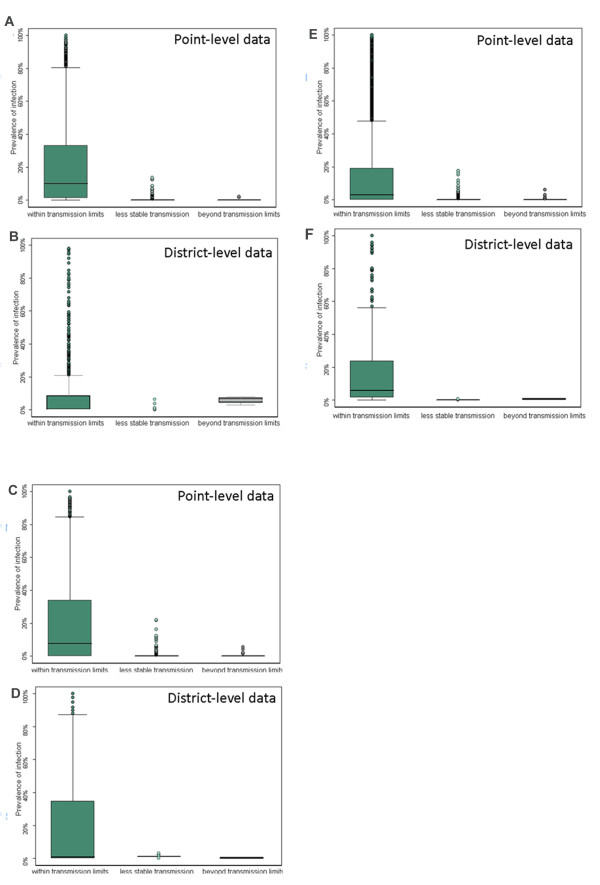
Box and whisker plots of the distribution of point and district level data by transmission category. Figures show hookworm (A, B), A. lumbricoides(C, D) and T. trichiura(E, F). The thick black line indicates the median, the box, the 25th and 75th percentile, whiskers indicate the range of the data and dots extreme outliers.